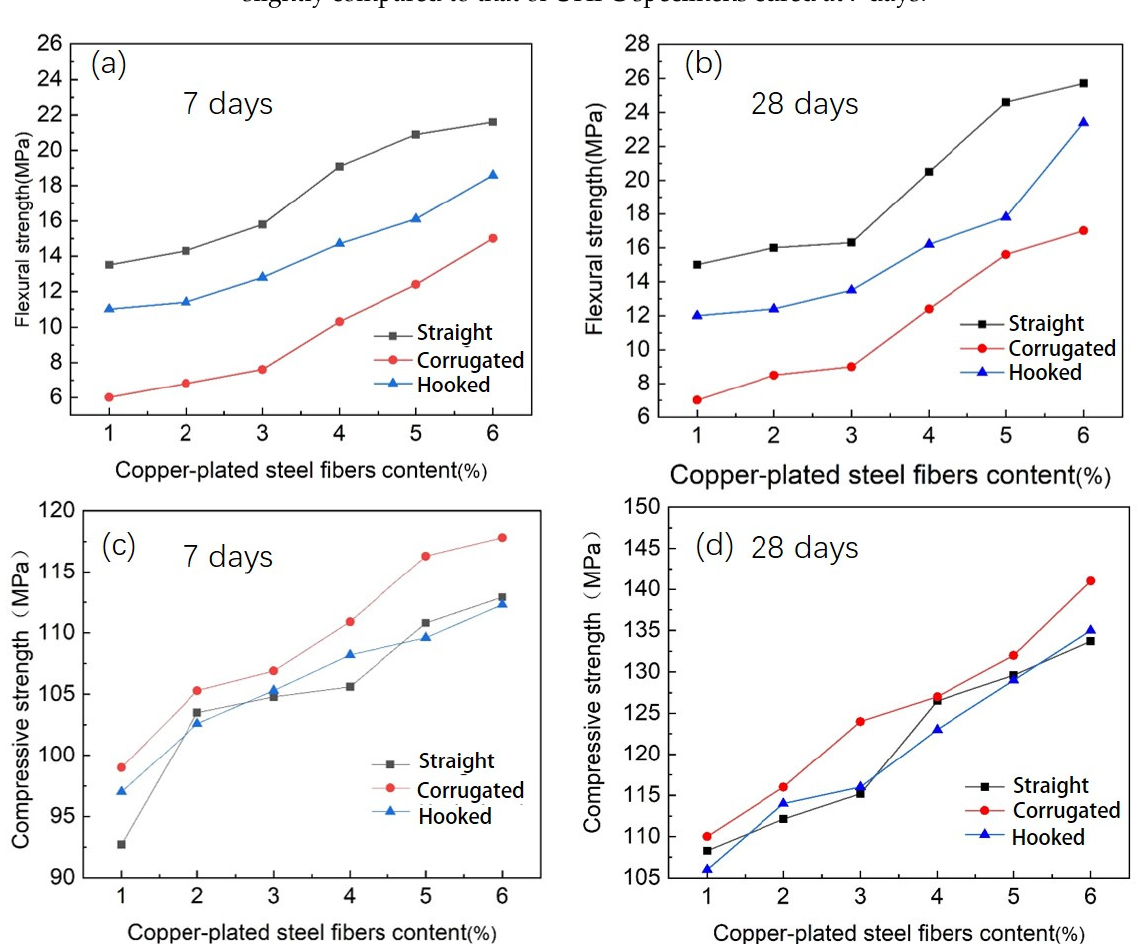
Figure 7. Flexural and compressive strength of three types of BCSF-reinforced UHPC with 1–6 wt.% cured at 7 days and 28 days: ( a , b ) 7 days; ( c , d ) 28 days; ( a , c ) flexural strength; ( b , d ) compressive strength.